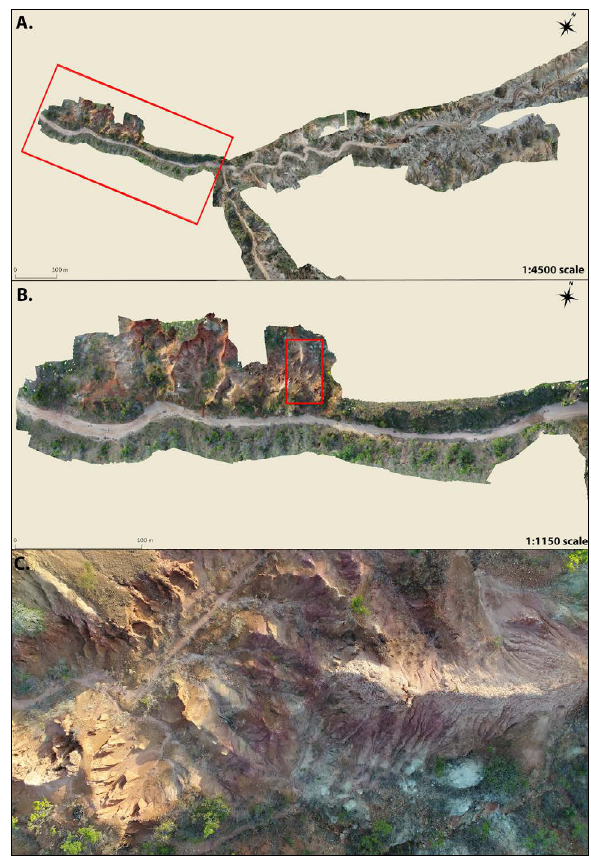
Figure 9: (a) Location of previously unmapped area, outlined in red. (b) Previously unmapped outcrops southwest of the natural junction, outlined in red. (c) Detail of the outcrops from an altitude of 40 m.